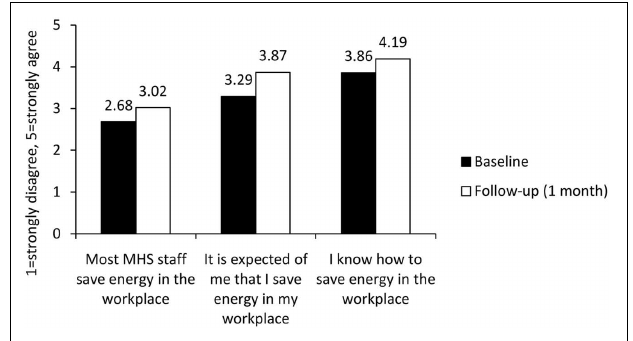
FIGURE 5 | Changes in norms and knowledge of energy conservation behavior.